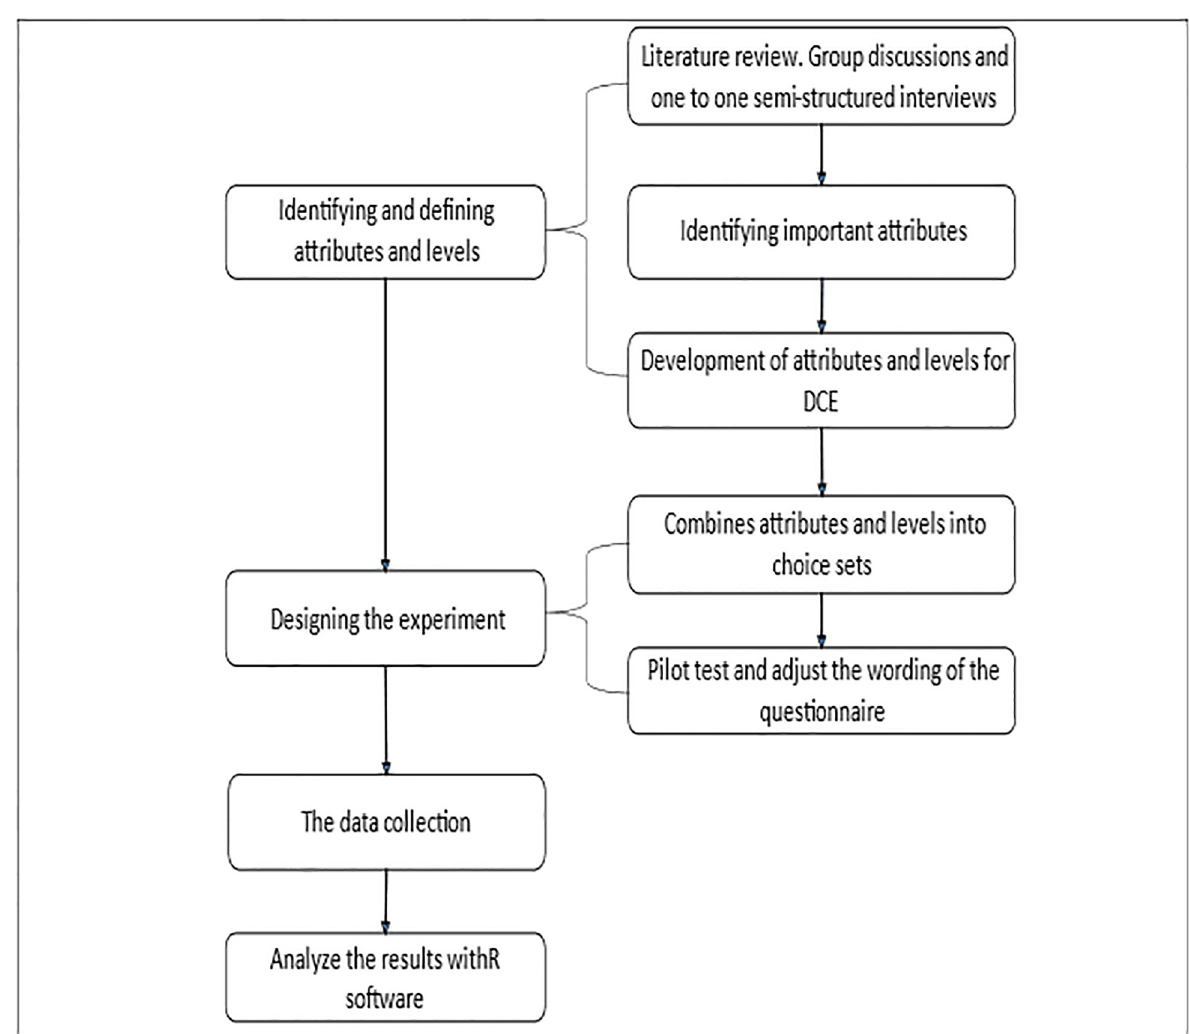
Fig 1. The development process of